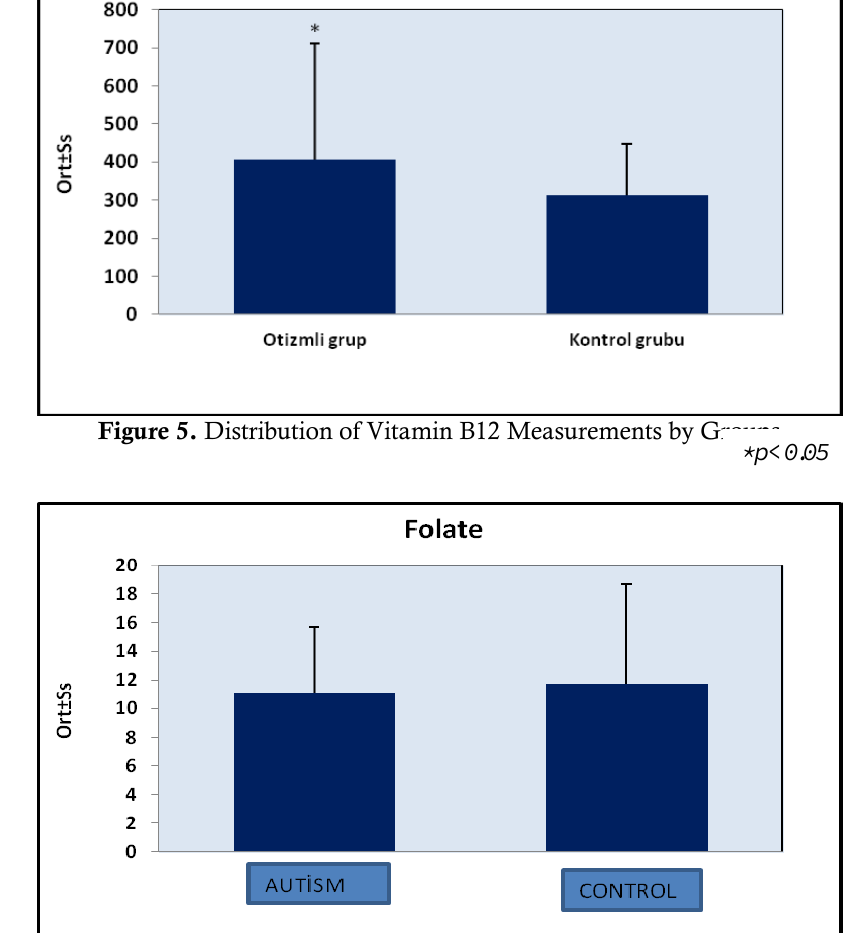
Vitamin and mineral levels in children with autism... | 99